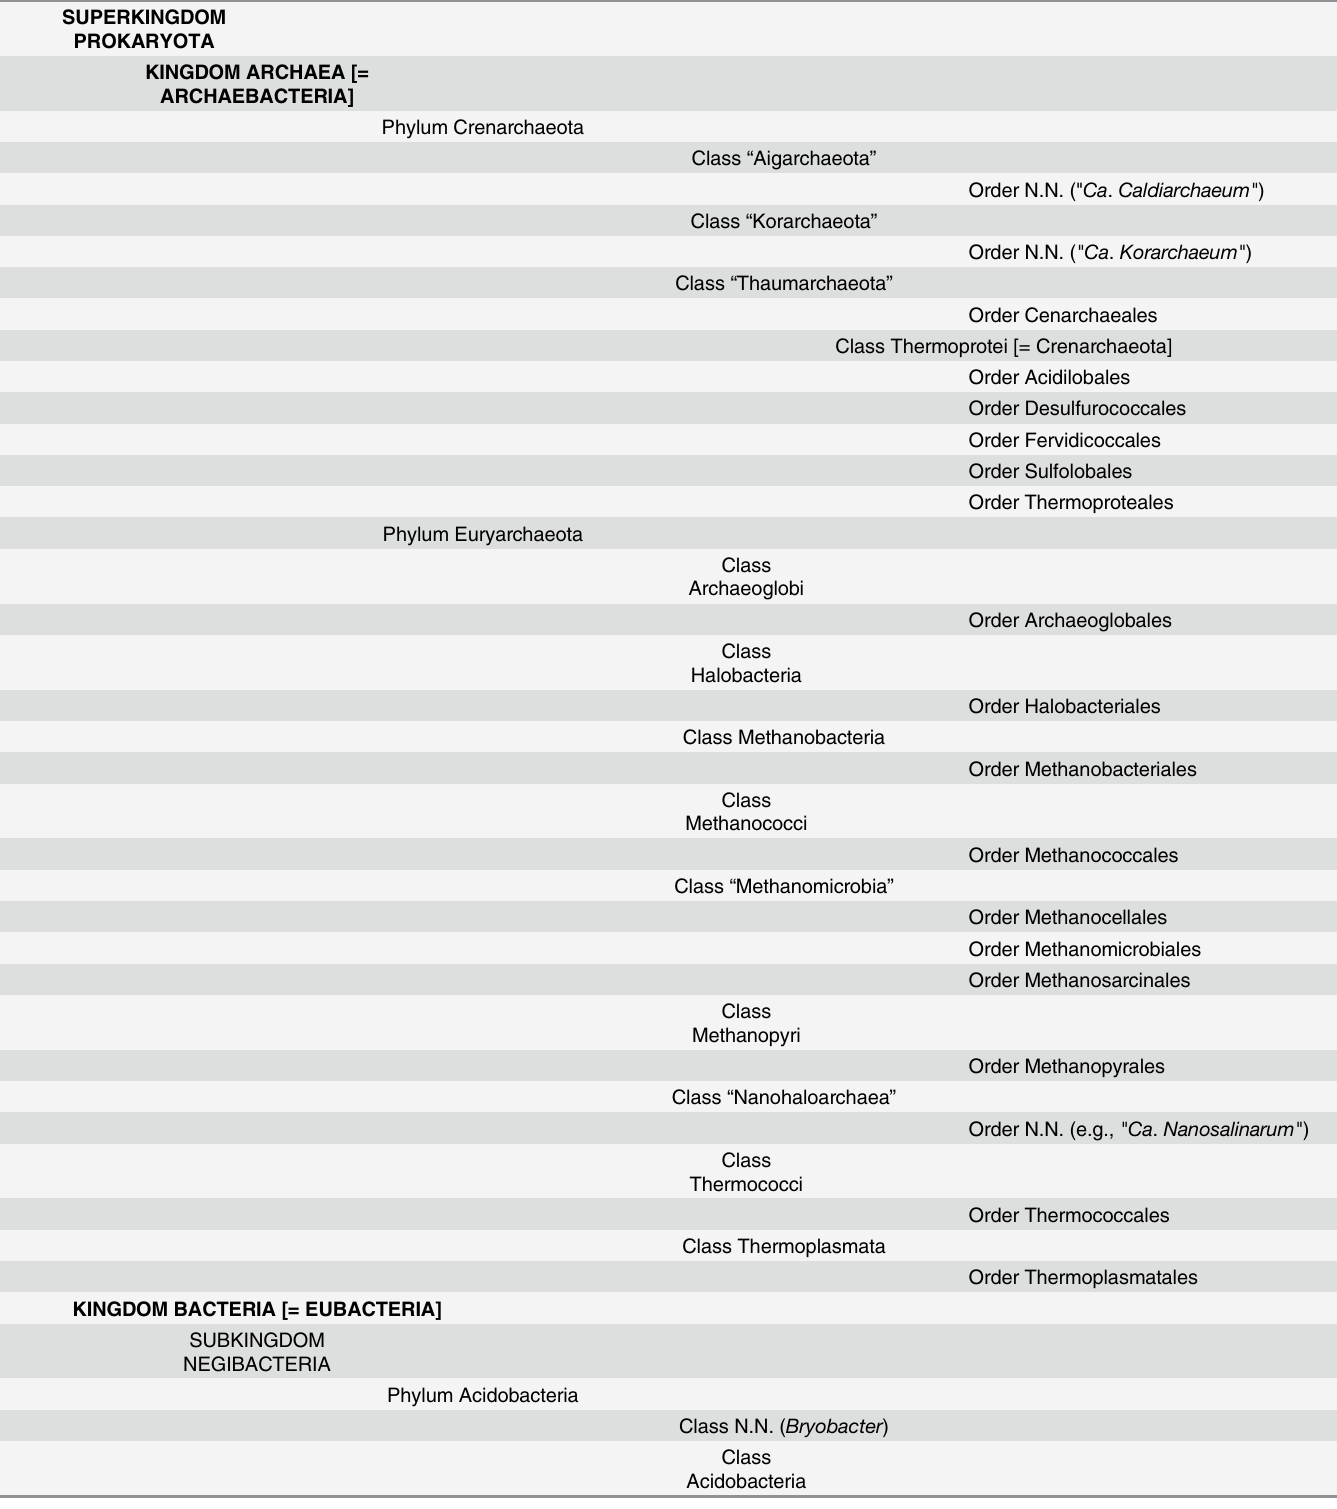
Table 2. Proposed hierarchical classification from superkingdom to